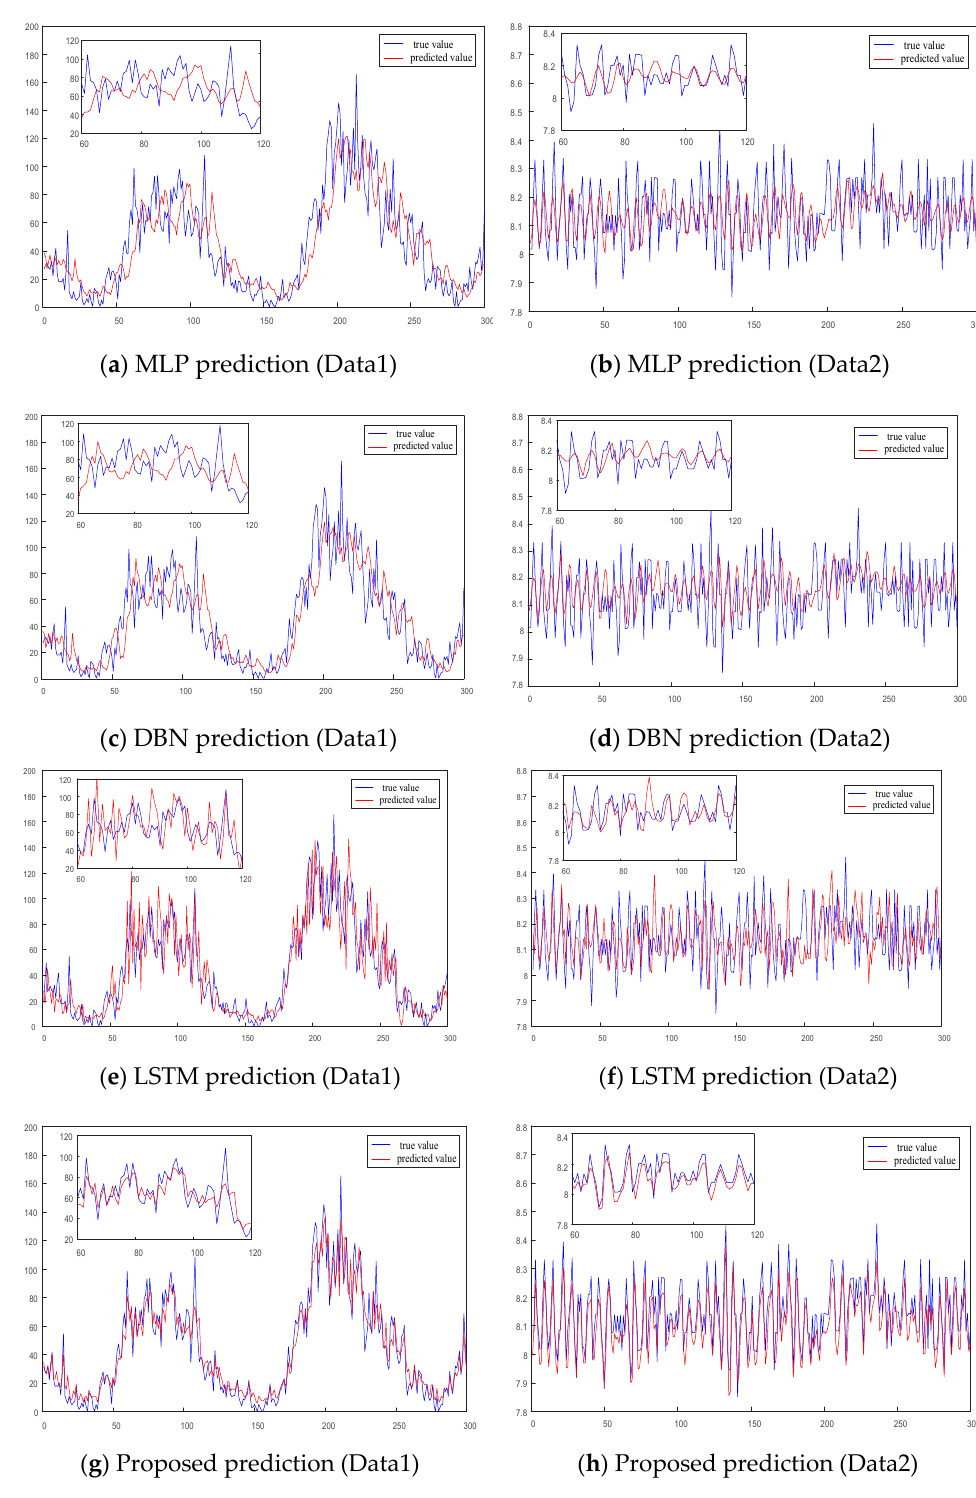
Figure 10. Multi-step prediction results. Similarly, in order to ensure the validity of the experimental results, all neural network models were trained for 10 times and the average value was taken. The prediction results of each method are shown in Table 4. Table 4. Comparison of prediction results of various methods under different data sets. Data sets Data1 Data2 Error MAE RMSE MAE RMSE MLP